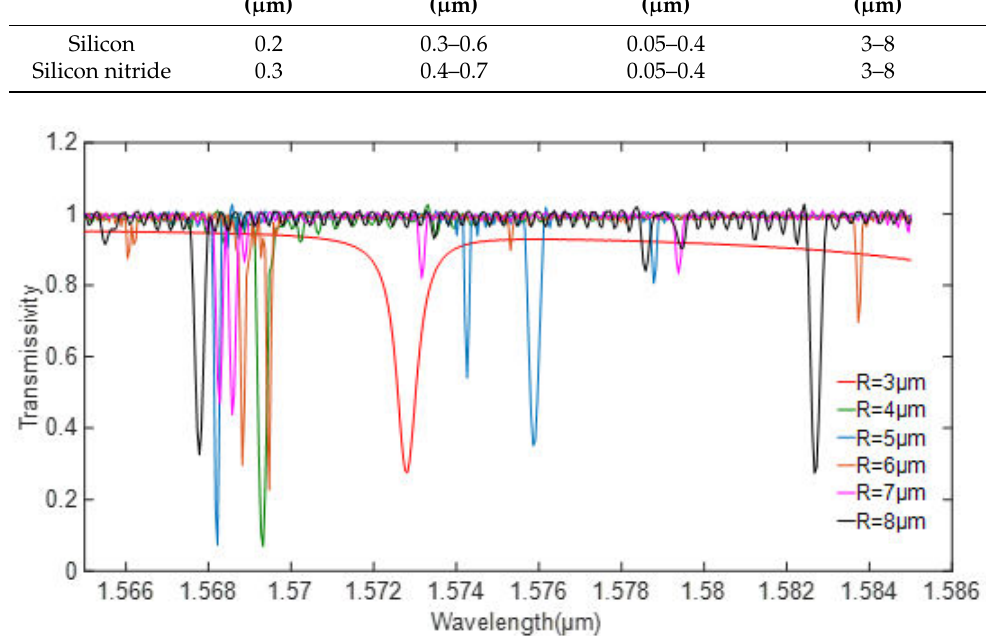
Figure 4. Relationship between the transmissivity and the radius of the silicon resonator.